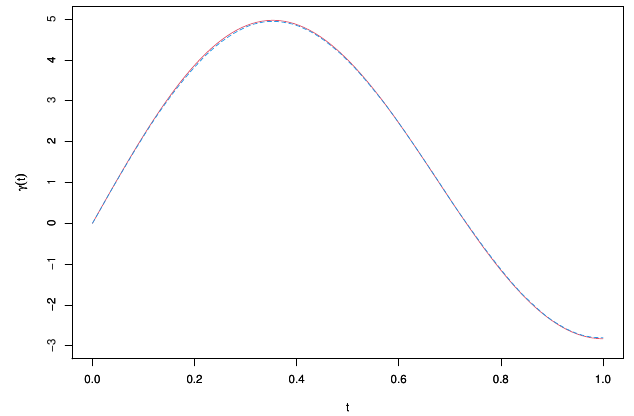
Figure 2. Simulation result of ˆ γ ( t ) when ρ = 0.7, R = 70, q = 5, σ 2 = 1. The solid curve denotes the true curve, the dash curve denotes its